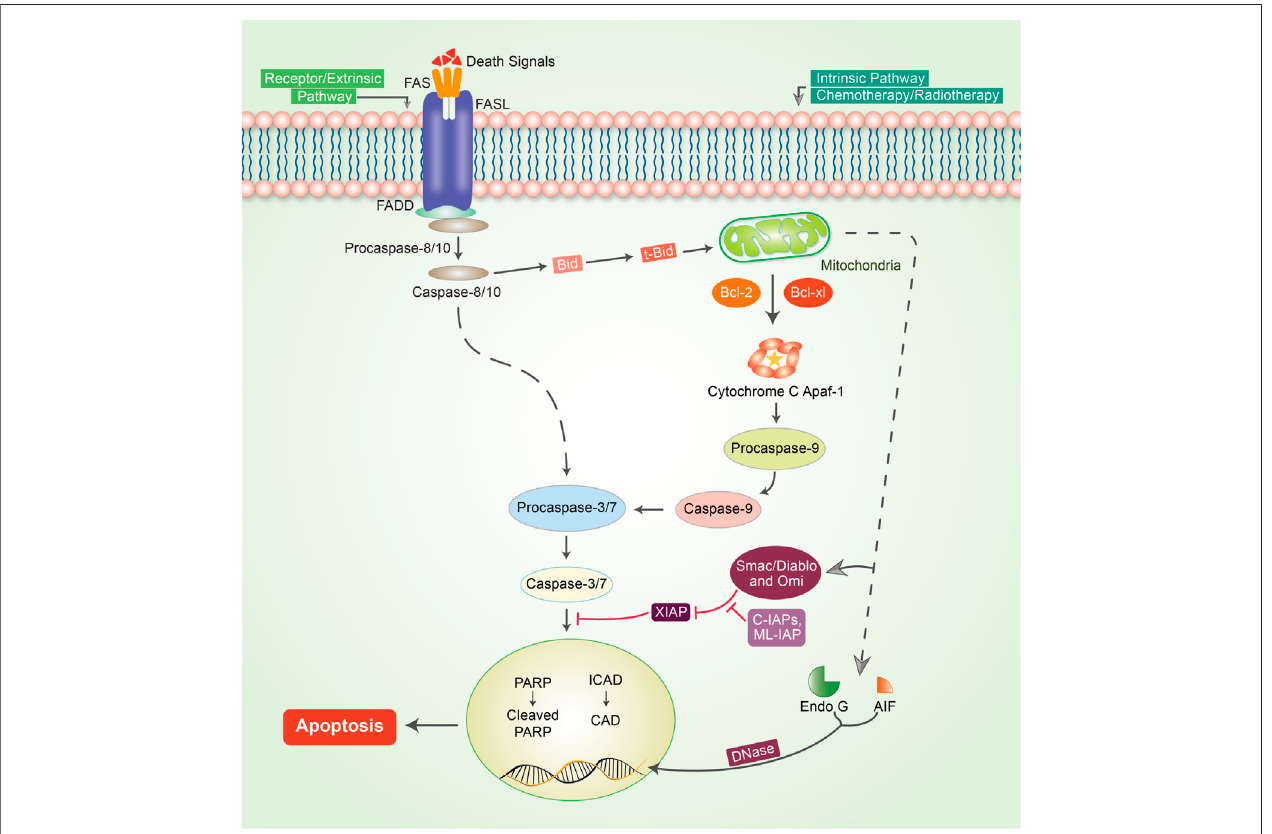
FIGURE 2 | Mechanism of the apoptotic pathway in cancer. To initiate apoptosis, two central pathways are involved in this mechanism: the intrinsic pathway and extrinsic pathway. The extrinsic pathway of apoptosis is well de fi ned by the TNF- α /TNFR1 and FasL/FasR models. Herein, the death receptor is induced by an adaptor protein; adaptor proteins are comprised of FADD (Fas-associated death domain) and TRADD (TNF receptor-associated death domain). The signaling that occurs through the extrinsic pathway causes the attachment of DRs to speci fi c death ligands (DLs), thereby forming a death-inducing signaling cascade (DISC). The complex pathway of caspase-8 activation follows a prede fi ned system that actively enables caspase-8 to detach from the DISC, whether or not the pro-domain of caspase-8 is retained as part of the DISC to initiate the signaling phases of apoptosis. However, in most apoptotic cells, proteins are customarily engaged in intrinsic phases that involve caspase-9, SMAC/DIABLO, Bcl-2, Bcl-w, Aven, Nox, and MYC. Mitochondrial dysfunction is followed by the loss of inner membrane mitochondrial potential, adequate formation of superoxide ions, impaired mitochondrial biogenesis formation, release of intra-membrane proteins, and matrix calcium glutathione burst, which enumerate the important potential for cancer therapeutic strategies by triggering the intrinsic phases of apoptosis in tumor cells. The execution phase of apoptosis initiator caspases, such as caspase-8/-9 or caspase-activated dnase (CAD), Poly (ADP-ribose polymerase (PARP), and other caspases such as caspase-3, -6, -7, and caspase-10, are typi fi ed as upregulator or executioner caspases. Caspase-3 is the most essential and effective of all effector caspases because it can be activated by all initiator